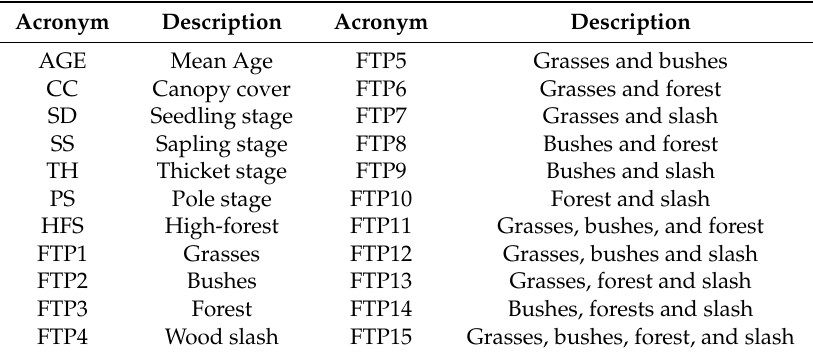
Table 1. Description of the 22 independent variables. The description of the fuel types is according to the EGIF